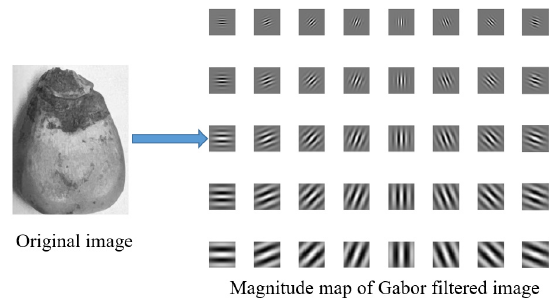
Figure 6. Diagram of Gabor wavelet transformation.